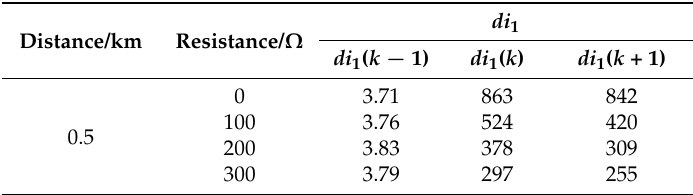
Table 2. Result of the protection starting-up element.